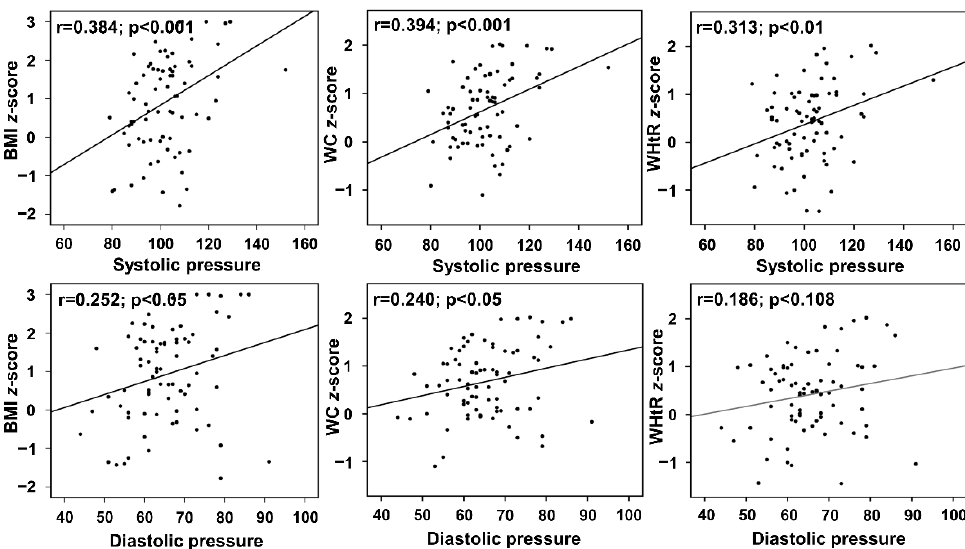
Figure 3. Relation between the anthropometric measurement (BMI z-score, WC z-score, WHtR z-score) with blood pressure (systolic and diastolic) and heart rate.